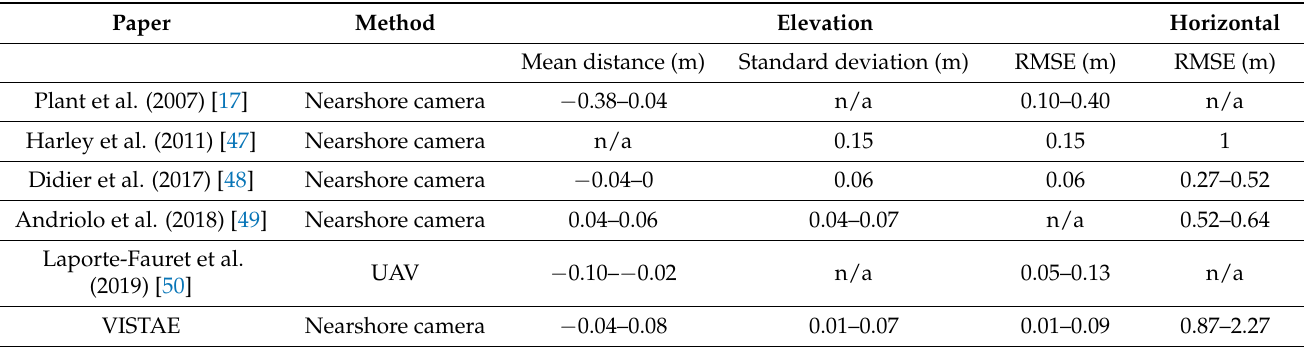
Table 3. Comparison of the performance of the VISTAE with recent literature dealing with coastal monitoring through field surveys and remote sensing data, in terms of vertical (Elevation) and horizontal